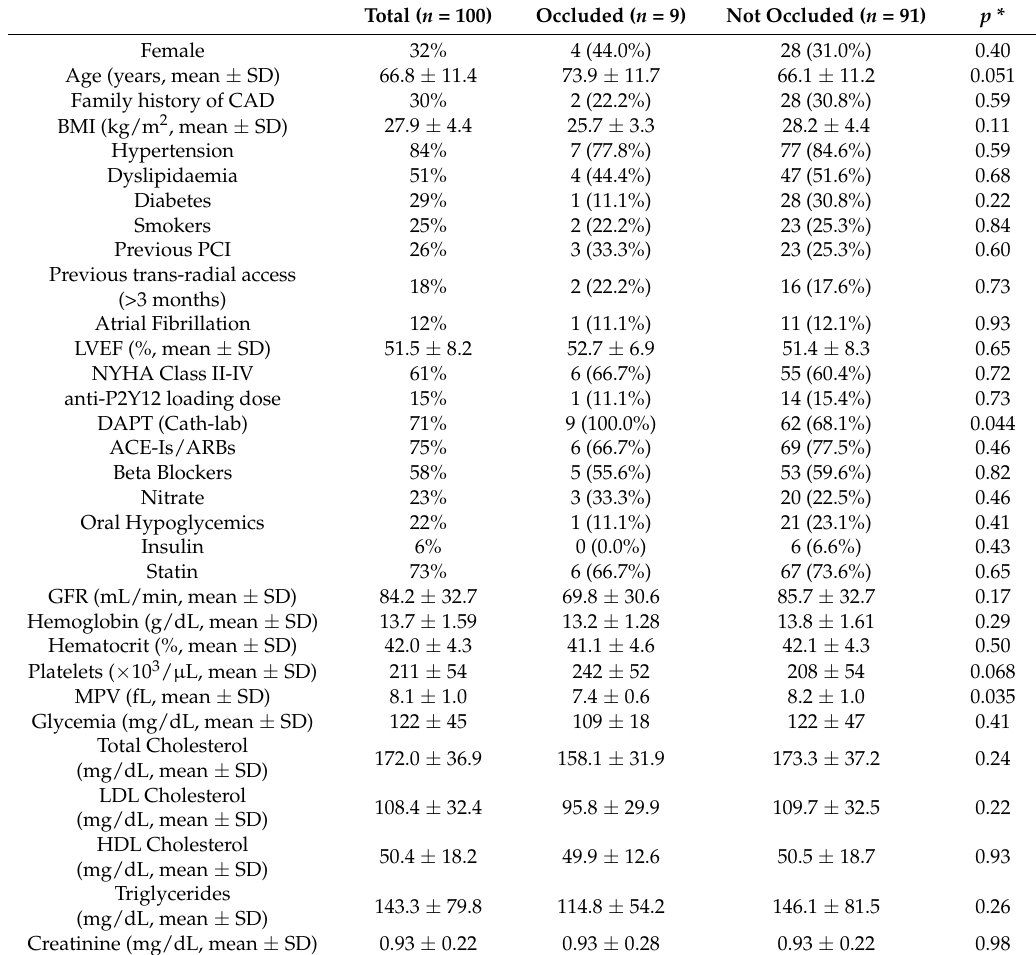
Table 1. Baseline patients’ characteristics according to radial artery patency